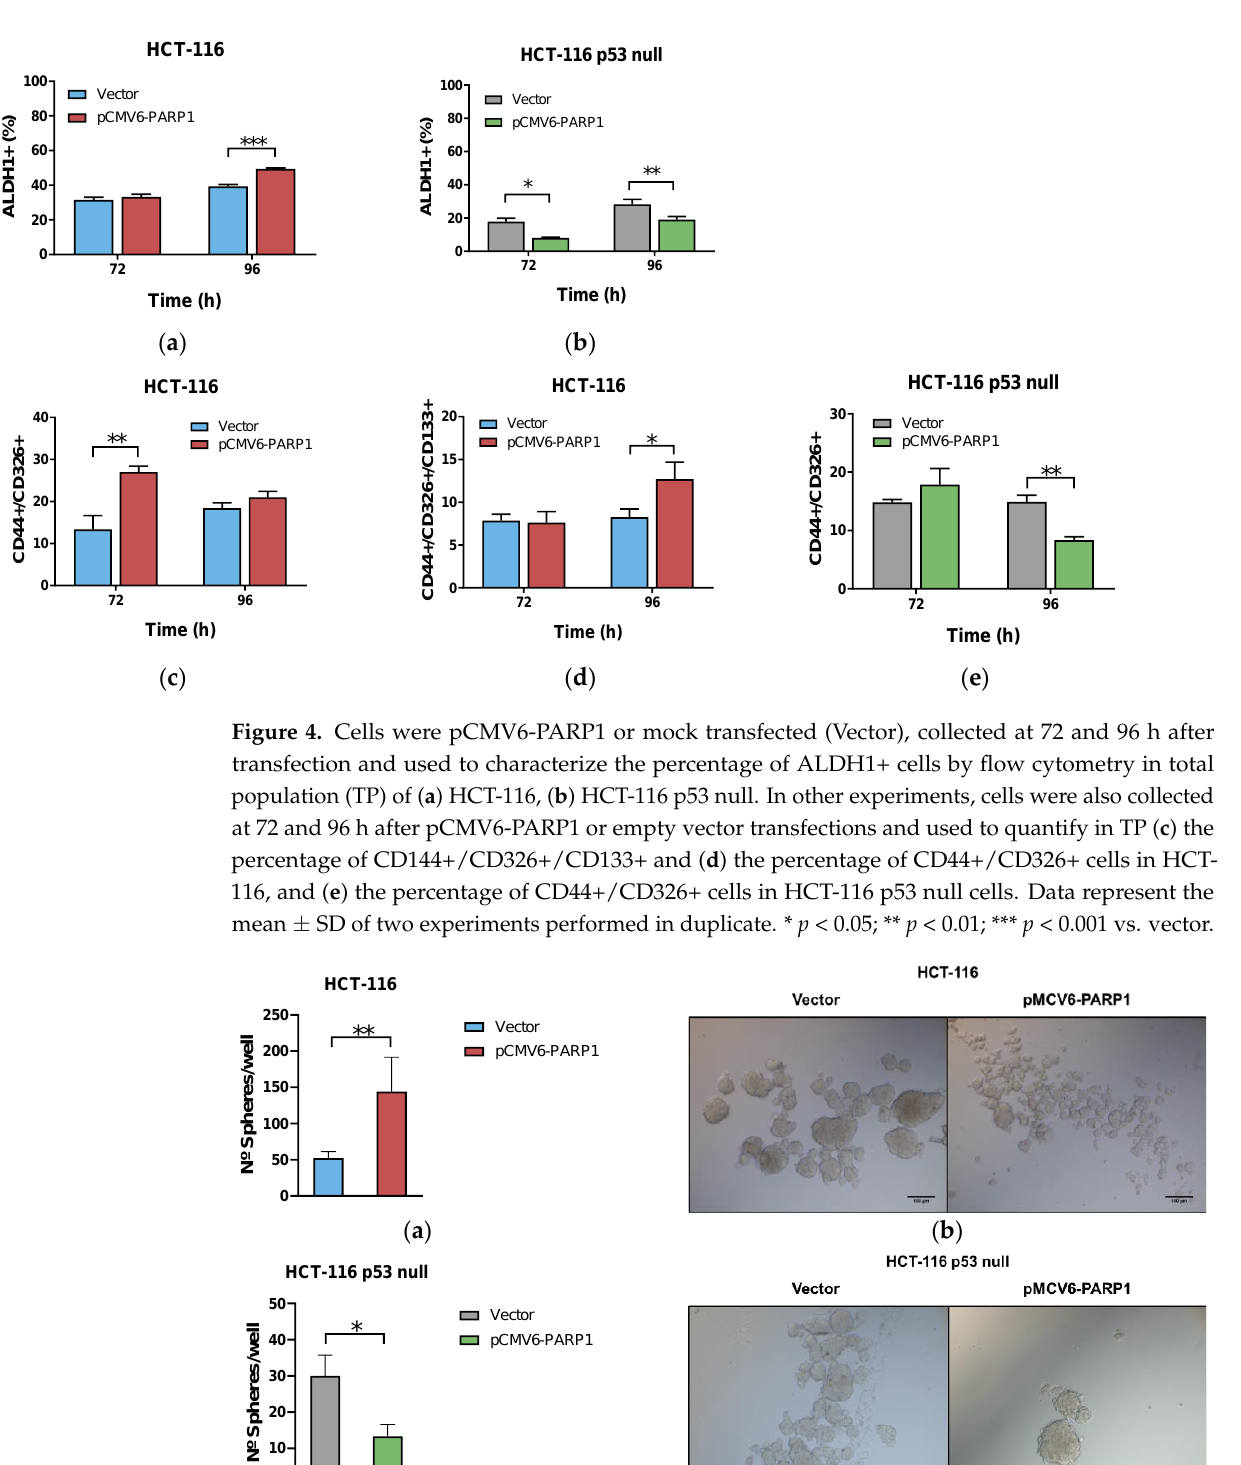
Figure 5. Influence of PARP-1 overexpression on sphere-forming ability of CRC in vitro. Number of spheres formed by cells obtained from mock and pCMV6-PARP1 ( a ) HCT-116 and ( b ) HCT-116 p53 null transiently transfected cells. Representative images of tumorospheres formed from pCMV6- PARP1, ( c ) HCT-116 and ( d ) HCT-116 p53 null transiently transfected cells. * p < 0.05; ** p <